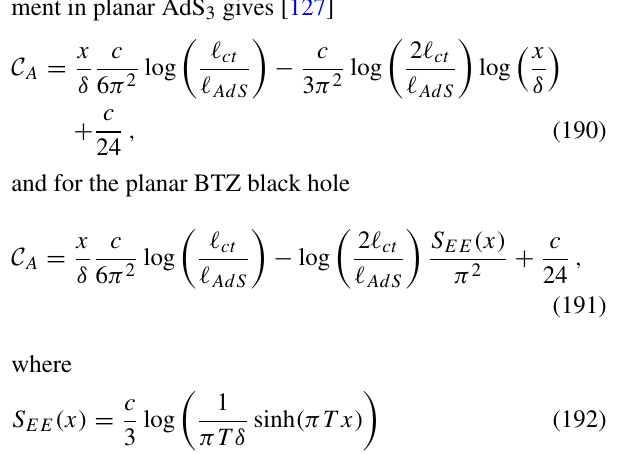
trated in Fig. 21. The timescale of the transition between the two asymptotic regimes (called the delay time in [117]) is not controlled by the scrambling time but is of order t d ∼ 1 / T